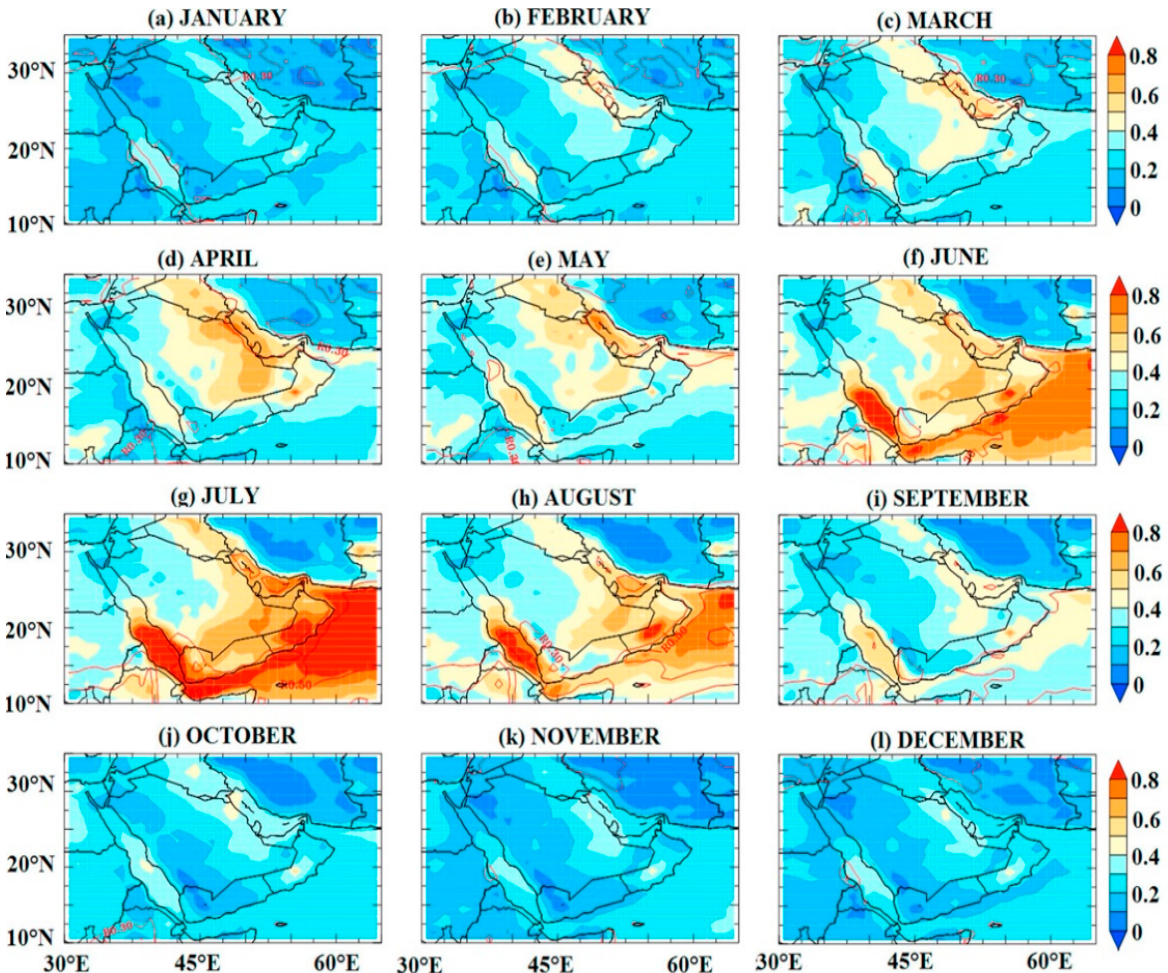
Figure 5. Monthly means of aerosol optical depth (AOD) and clearness of the sky over the GCC region computed for 2003–2017. Copyright © 2021 Elsevier [55].